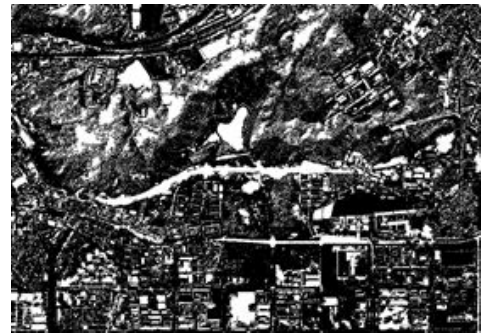
Figure 8. Region growing segmentation